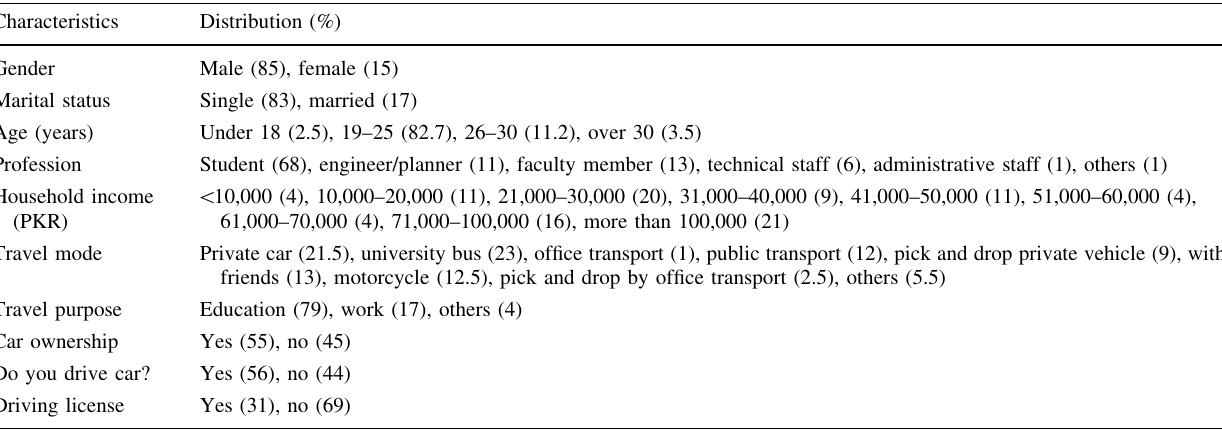
Table 1 Distribution of respondents’ personal and travel information